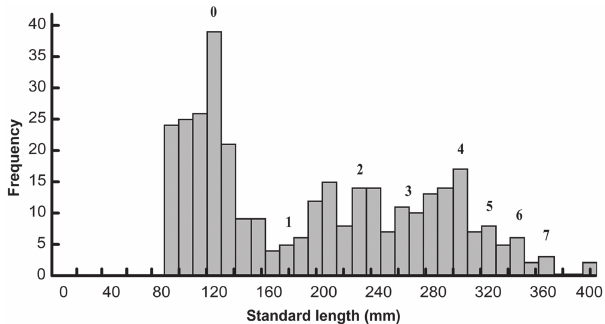
Fig. 2. Annual length frequency distribution of Ecuadorian Prochilodus nigricans collected from the Aguarico River in 1999. Numbers above bars indicate average size at each age estimated from otolith data (Silva, Stewart, 2006).